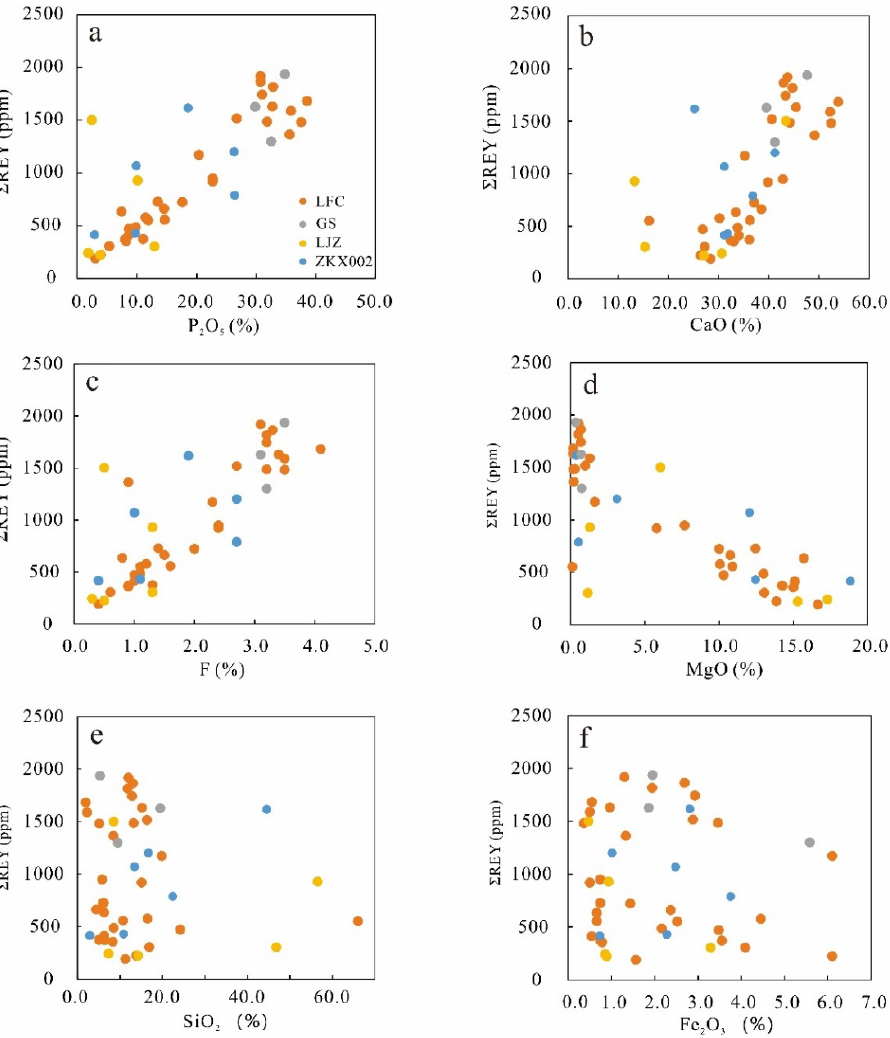
Figure 5. The correlations between ΣREY and some major elements in phosphorite from the Zhijin region. ( a ) ΣREY vs. P 2 O 5 . ( b ) ΣREY vs. CaO. ( c ) ΣREY vs. F. ( d ) ΣREY vs. MgO. ( e ) ΣREY vs. SiO 2 . ( f ) ΣREY vs. Fe 2 O 3 .